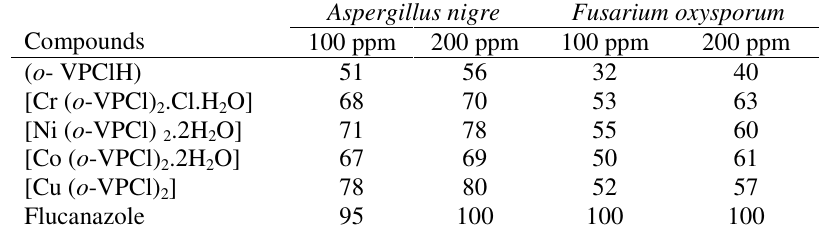
Table 6. Antifungal activity of the Schiff base ligand and their metal complexes, showing of diameter of inhibition